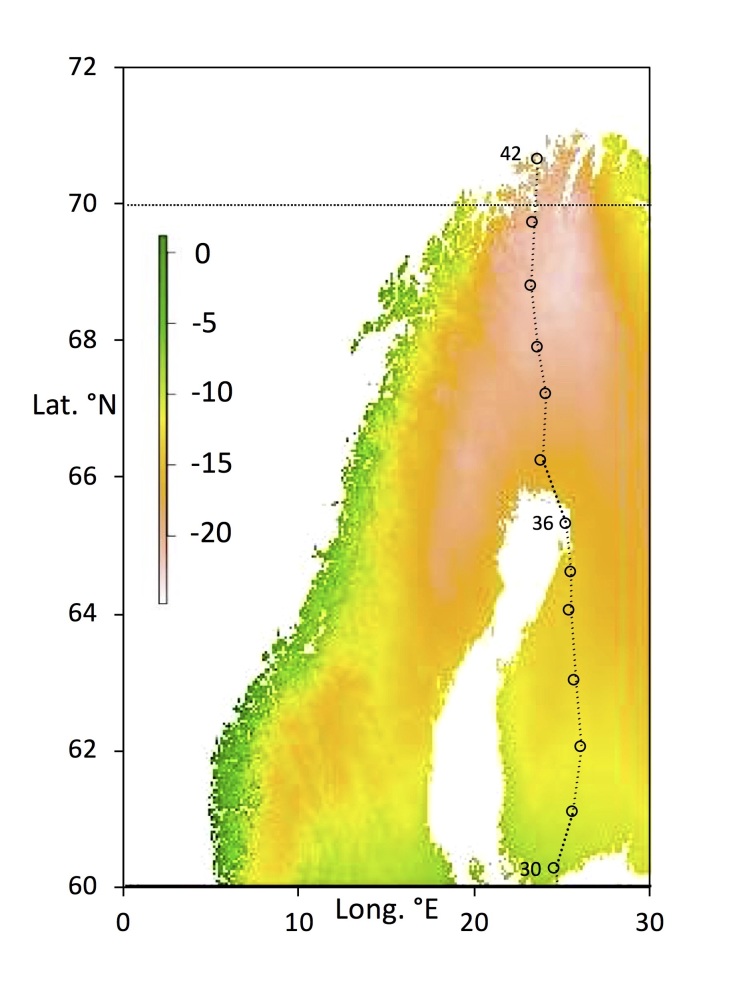
Northern sites (numbers 30 – 42; Lat. 60.27°N–70.65°N), showing the distribution of extreme low winter temperatures in Fennoscandia, as mean minimum monthly temperature for January (scale in °Celsius).